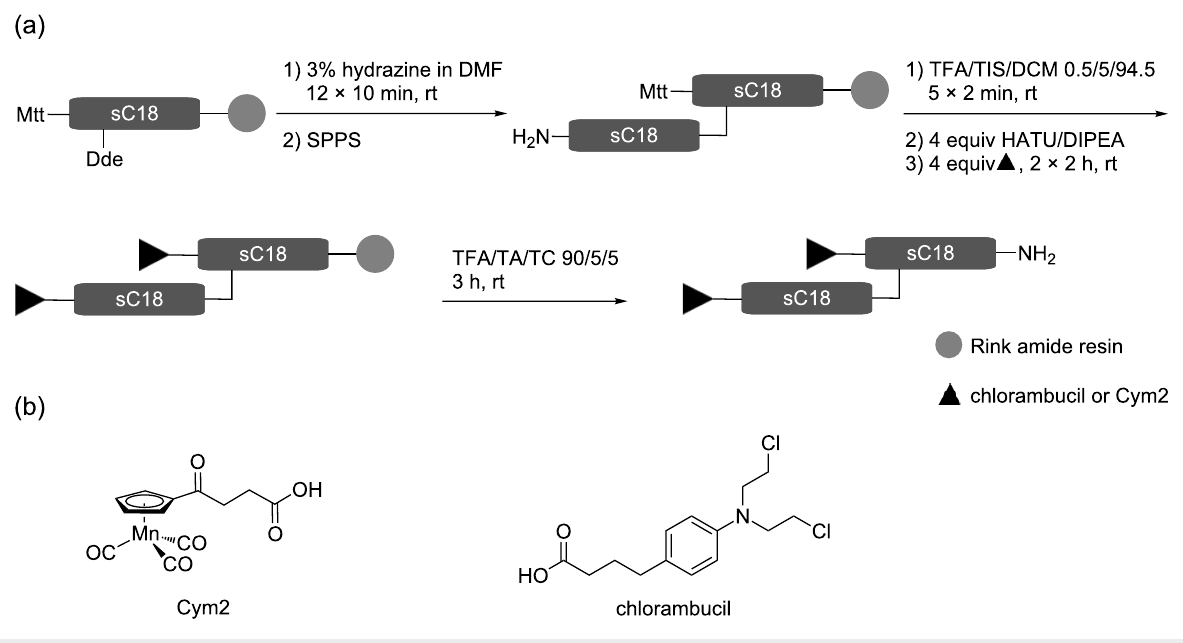
Scheme 1: Synthesis of (sC18) 2 bioconjugates (a) and chemical structures of the coupled anti-tumor agents (b). Mtt: 4-methyltrityl chloride; Dde: 1-(4,4-dimethyl-2,6-dioxocyclohex-1-ylidene)ethyl; SPPS: solid-phase peptide synthesis; TFA: trifluoroacetic acid; TIS: triisopropylsilane; HATU: